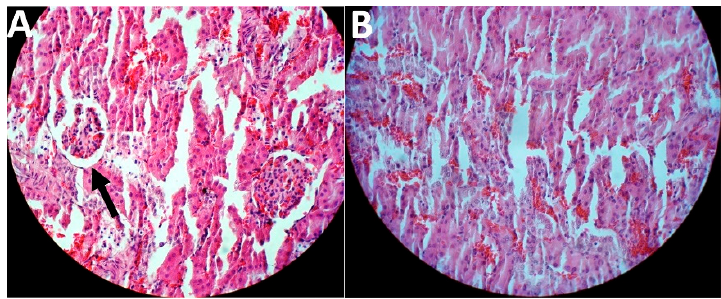
Figure 10. Histological evaluation of kidney tissue in kidney cancer-bearing rats received ( A ) the standard cisplatin and ( B ) cisplatin-loaded PBCA nanoformulation. The arrow shows ATN.